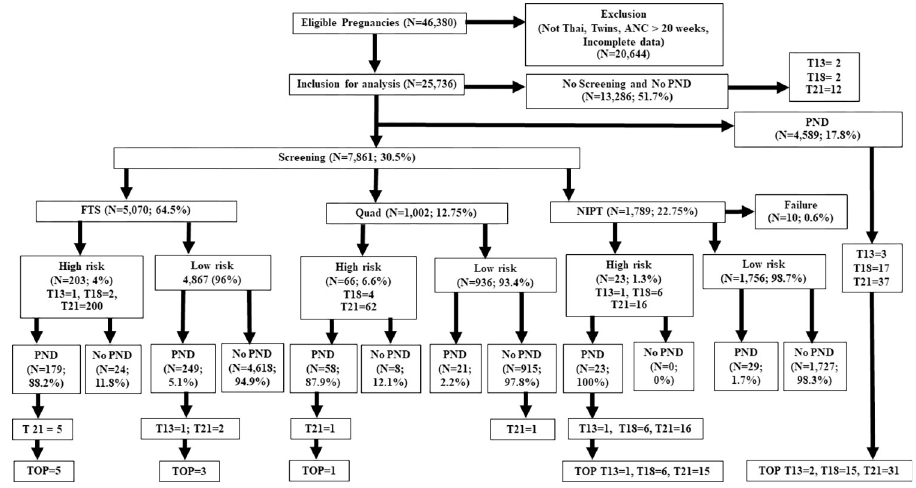
Fig 1. Flow chart of participants recruitment and overall design. FTS, first-trimester screening test; Quad, quadruple test; NIPT, non-invasive prenatal testing; PND, prenatal diagnosis test; TOP, Termination of pregnancy.